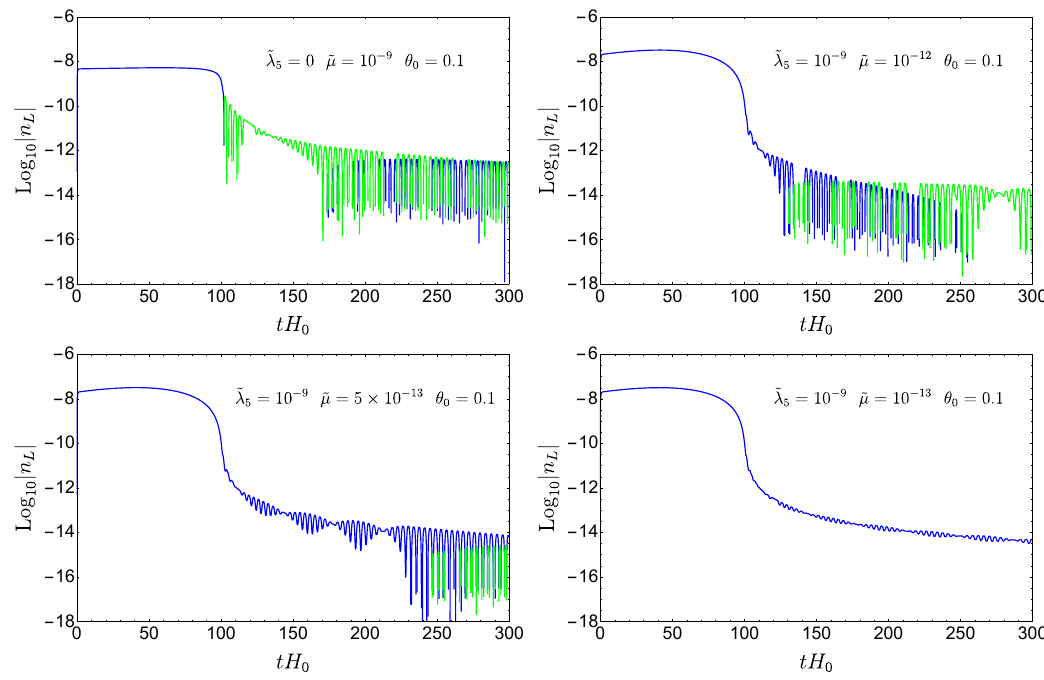
Figure 4 . The lepton number density during inflation and the oscillatory epoch for varying values of the cubic coupling term ˜ µ , where we define H positive and negative lepton number densities respectively, and n The input parameters are fixed to ξ = 300 and λ = 4 . 5 · 10 − 5 , with initial conditions χ ˙ χ = 0 , and ˙ θ = 0 0 0